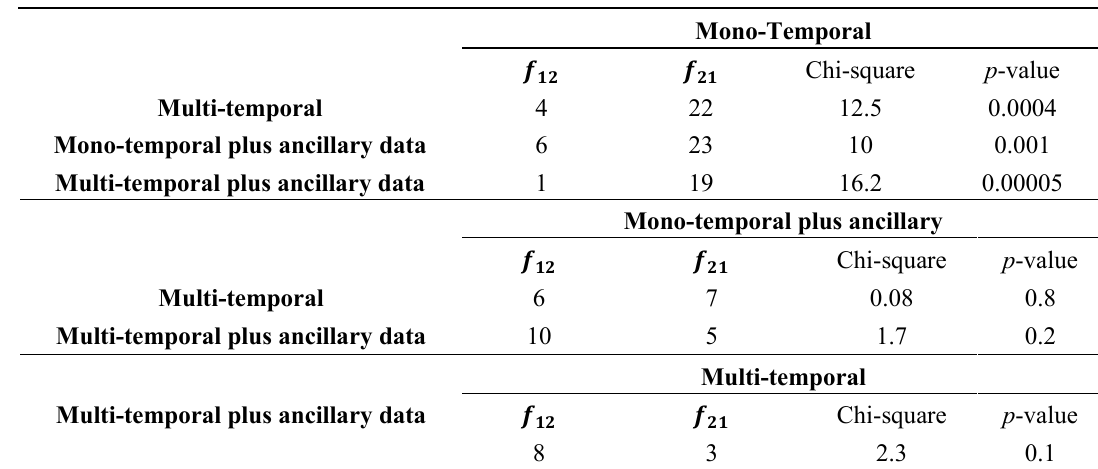
Table 12. McNemar’s test results between image